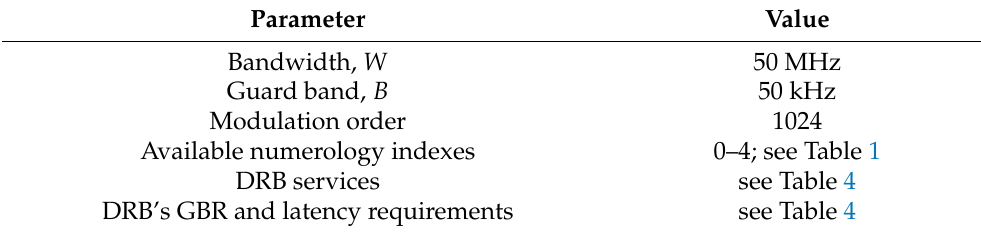
Table 7. Simulation